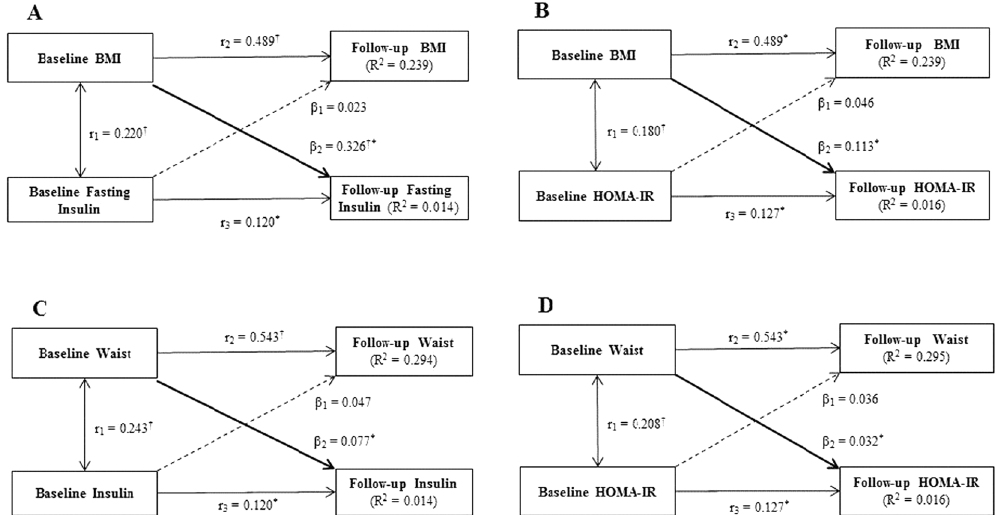
Figure 2. Cross-lagged path analysis of BMI or WC and insulin or HOMA-IR in the Harbin People Health Study, adjusted for age, sex, and follow-up years. β 1 and β 2 are cross-lagged path coefficients; r 1 is synchronous correlations; r 2 and r 3 are tracking correlations; R 2 is variance explained. Coefficients different from 0: * P < 0.01, † P < 0.001 for difference between β 1 and β